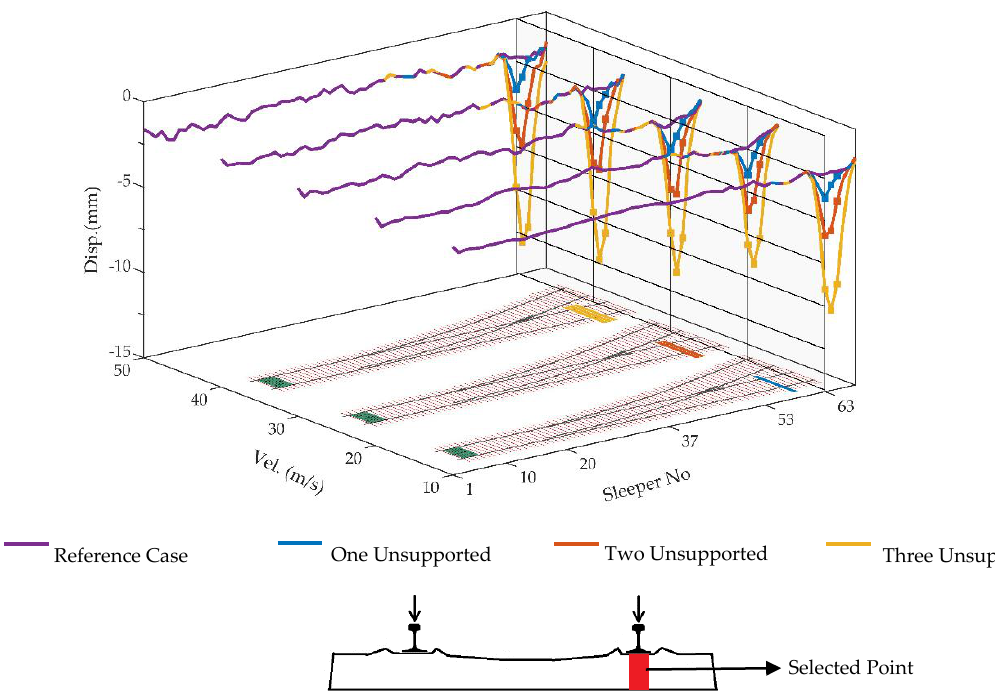
Figure 9. The maximum displacement of bearers at rail seats when the shortest bearer is unsupported.